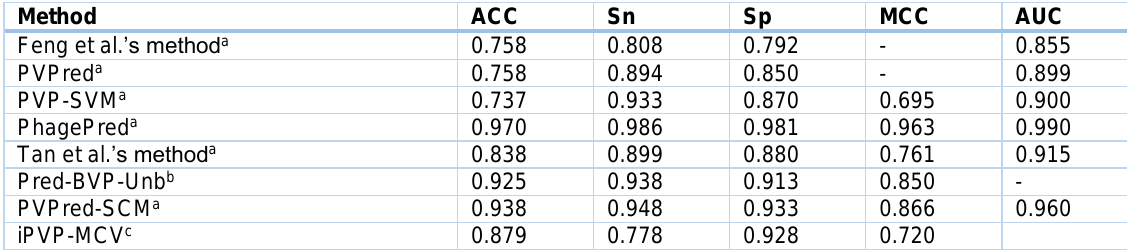
Table 4: Cross-validation results for different PVP predictors evaluated on the Feng2013 dataset Method